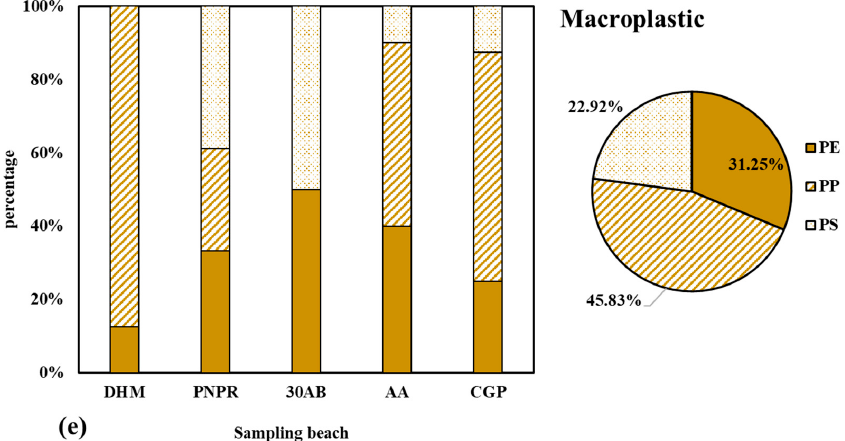
Figure 3. Physical characteristics and composition of microplastics in beach sand of this study. ( a ) Percentage of different sizes of microplastics; ( b ) Percentage of different shapes of microplastics; ( c ) Percentage of different sizes of microplastics; ( d ) Percentage of different compositions of microplastics; ( e ) Percentage of different compositions of macroplastics.